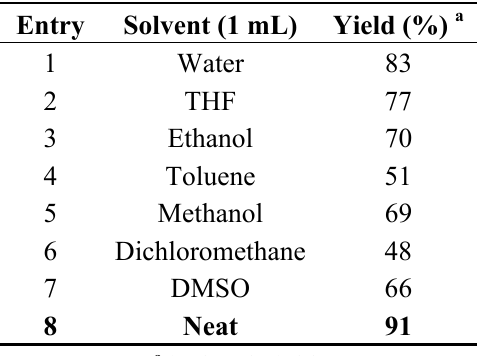
Table 1. Microwave-assisted (300 Watts, 90 °C, 24–50 psi) synthesis of 3-pyrrole substituted 2-azetidinones from 1 mmol of (±)- trans 3-amino-1-(chrysen-6-yl)-4- phenylazetidin-2-one with 1.2 mmol of 2,5-dimethoxytetrahydrofuran using molecular iodine as catalyst (20 mol%) for 3 min: solvent